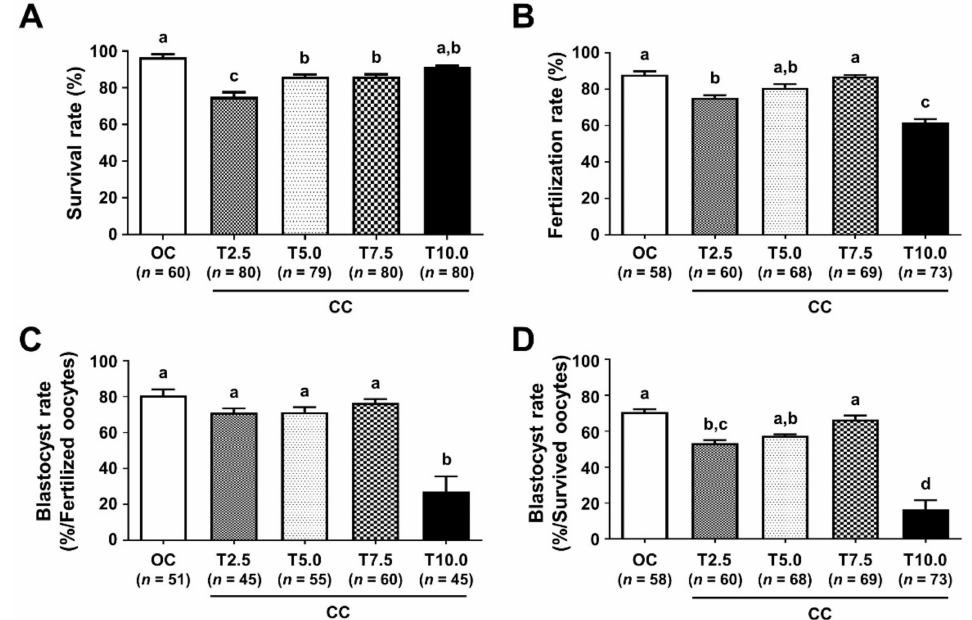
Figure 5. Comparison of the survival and development rates of vitrified/warmed (VW) oocytes with different CPA exposure times. Comparison of the survival ( A ), fertilization ( B ), and blastocyst formation rates ( C , D ) of VW oocytes with different carrier systems. Blastocyst formation rates (the number of blastocysts/the number of fertilized oocytes ( C ) and/the number of survived oocytes ( D )). Different superscript letters (a–d) indicate p < 0.05. The number of experiments = 3 (23–28 oocytes per group in each experiment). OC, open carrier system; CC, standard exposure time (2.5 min, CC-T2.5) to equilibrium solution in closed carrier system; CC-T5.0, CC-T7.5, and CC-T10.0, exposure time increased to 5.0, 7.5 and 10.0 min in the equilibrium solution,